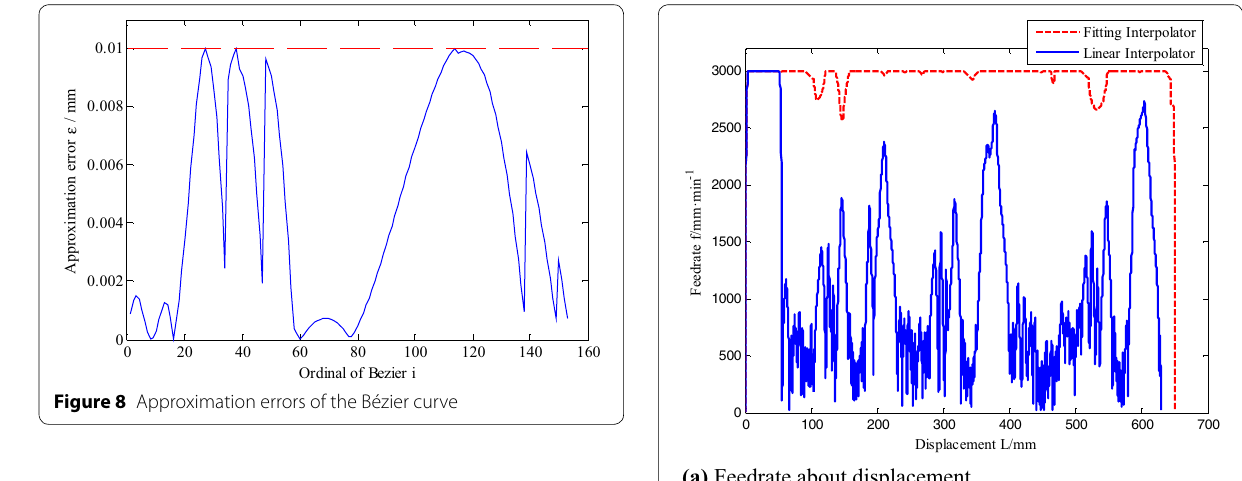
(a) Feedrate about displacement